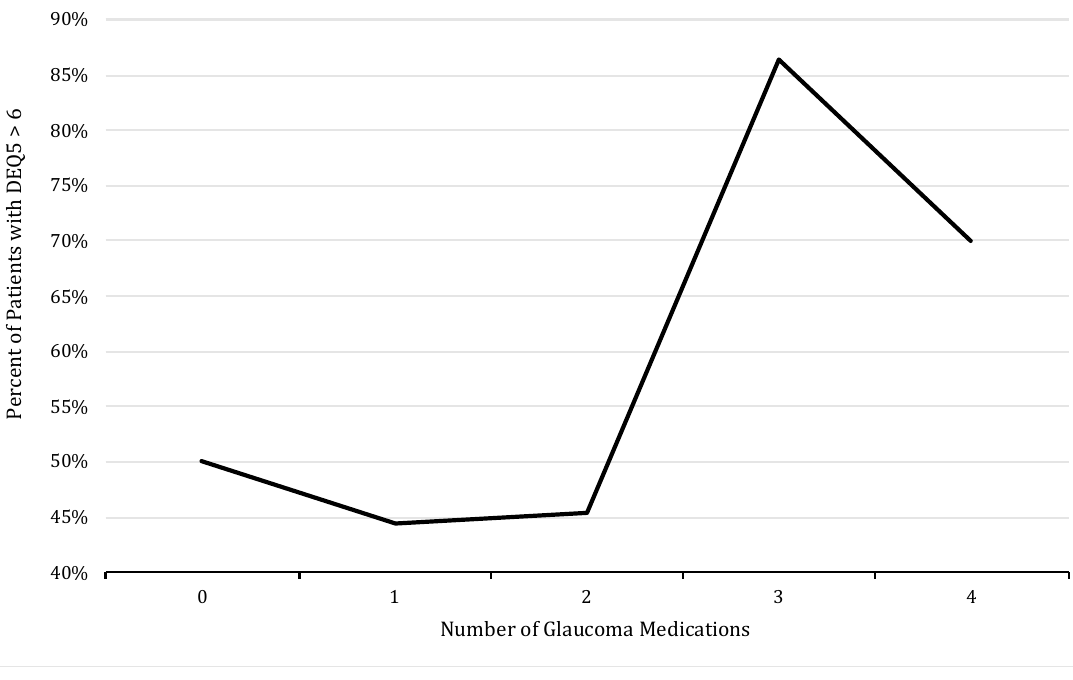
Figure 1. Percent of glaucoma patients, classified by number of medications used, with a five item Dry Eye Questionnaire (DEQ5) score of >6, indicating mild or greater dry eye symptoms.